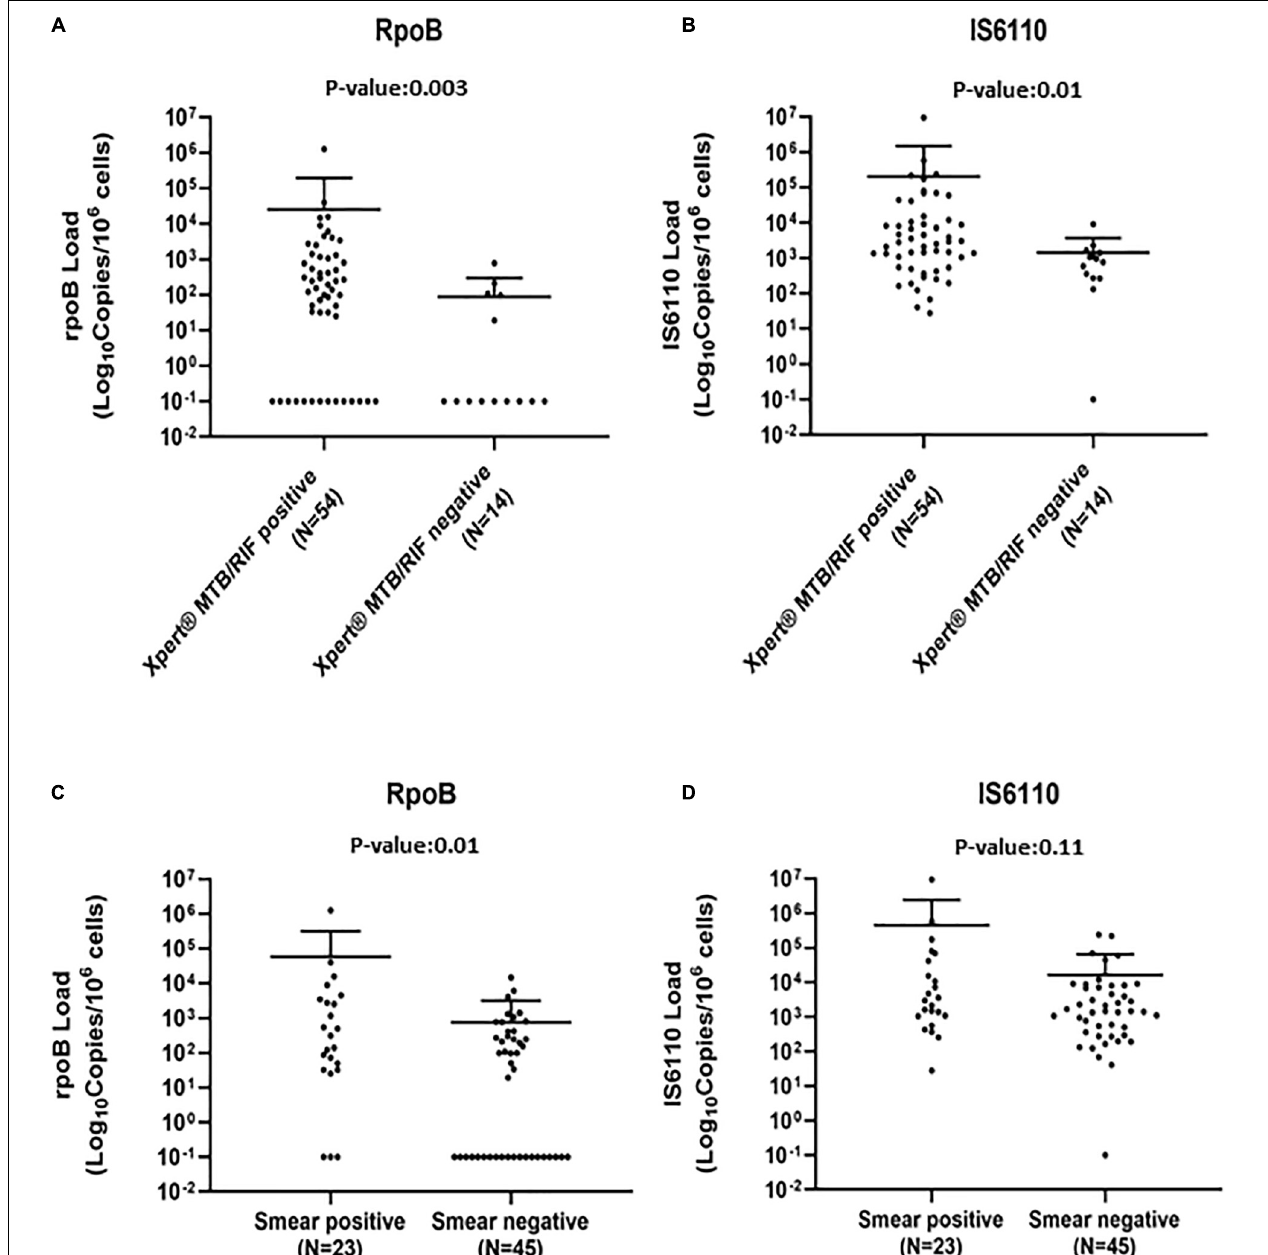
FIGURE 2 | Mycobacteria tuberculosis (MTB) rpoB and IS6110 load against Xpert (A,B) and acid-fast bacilli (AFB) smear (C,D) results. Each value was represented by a dot; bars represent median and interquartile range (IQR). p -Values were calculated by Wilcoxon rank sum test and Kruskal–Wallis where